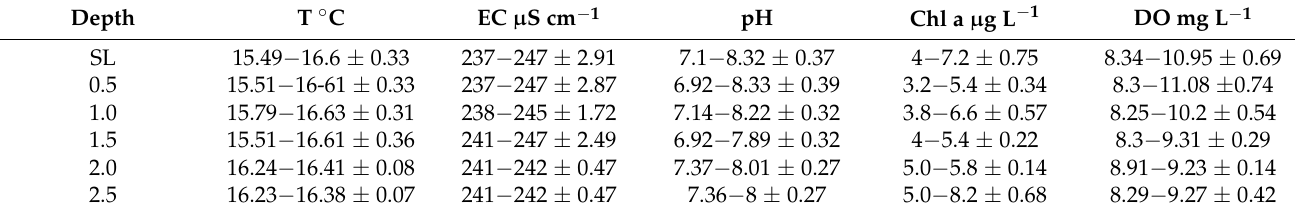
Table 2. Range of values of selected water quality parameters (min–max ± standard